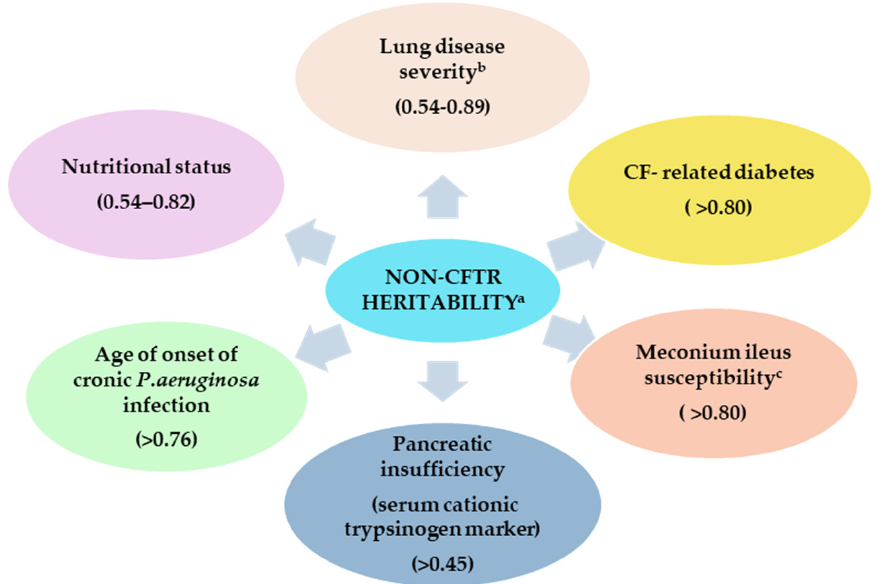
Figure 2. Heritability estimates for cystic fibrosis related phenotypes established from twins and sibling studies [74,85,87–92]. a refers to the heritability that is not due to differences in phenotype that occur across different CFTR mutations; b depending on the method used for evaluation; c in CF patients with two severe mutations and pancreatic insufficiency .